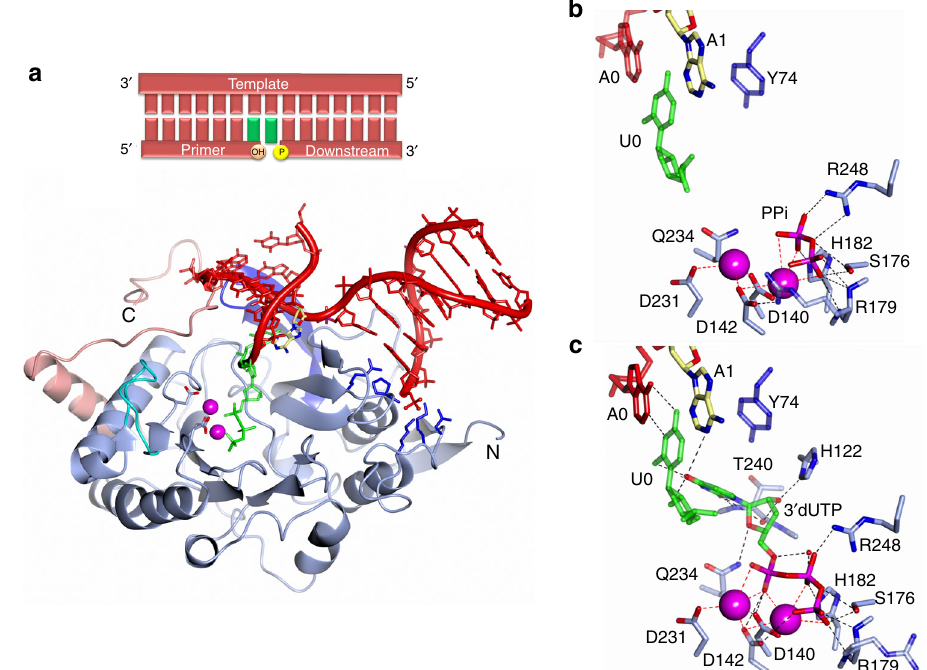
Fig. 5 Crystal structures of post-catalytic Prim – PolC – DNA complexes. a Schematic of the 1-nt gapped post-turnover DNA substrate found in this pre- ternary post-catalytic complex (top panel). A ribbon-diagram representation of the post-catalytic Prim – PolC – DNA – NTP complex (bottom panel). The catalytic core is coloured sky blue, with the conserved loop structures from this family coloured dark blue, cyan and pink for Loops 1 – 3, respectively. The catalytic aspartate side chains are represented with the carboxylic oxygens shown in red, and bound manganese ions depicted as magenta spheres. Side chains involved in forming the 5 ′ phosphate-binding pocket are depicted in dark blue. Active- site geometries of the two forms of post-catalytic turnover Prim – PolC:DNA complex. b In this post-catalytic complex, nucleotidyl transfer has occurred, and inorganic phosphate (PPi) remains bound in the active site. The gate residue, R179, is in the closed conformation, preventing PPi from leaving. All the hydrogen bonds are depicted in black hatched lines, and dative bonding in red hatched lines. Catalytic manganese ions depicted as magenta spheres. c In this post-catalytic complex, PPi has left the active site, and R179 remains in the open conformation, allowing the binding of the next incoming 3 ′ -dUTP in readiness for the next round of catalysis. Regions or side chains that have poor density are represented as transparent